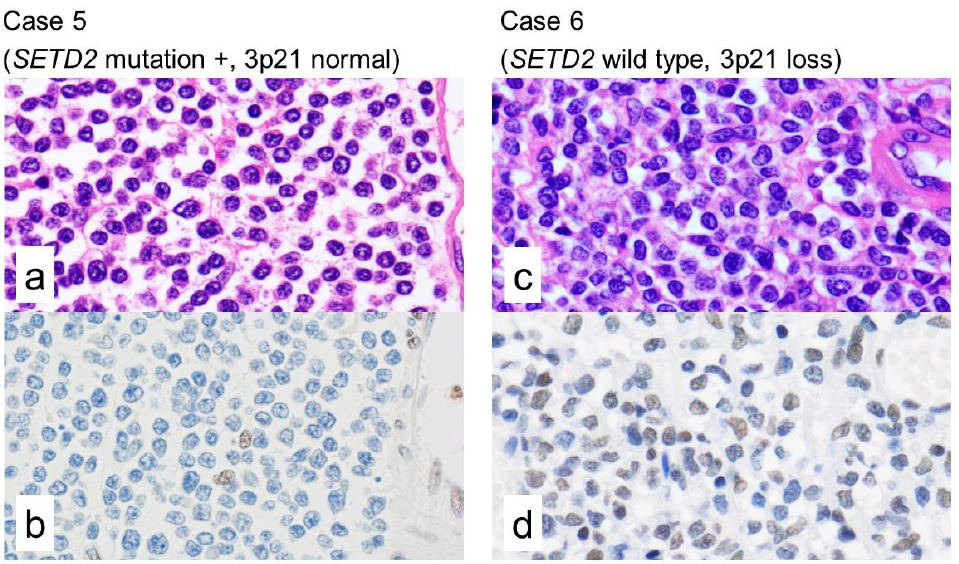
Figure 2. Morphology and immunohistochemical staining for H3K36me3. H3K36me3 is an epigenetic modification to the DNA packaging protein Histone H3. It is a mark that indicates the tri-methylation at the 36th lysine residue that, among other functions, maintain the gene expression trimethylation is catalyzed by SETD2, that acts as a tumor suppressor gene (TSG). Among the nine examined cases by IHC, all the seven SETD2 -mutated cases were negative for H3K36me3. Only cases 6 and 8 had no SETD2 mutation. Case 5 ( SETD2 mutation and normal copy number of 3p21) showed